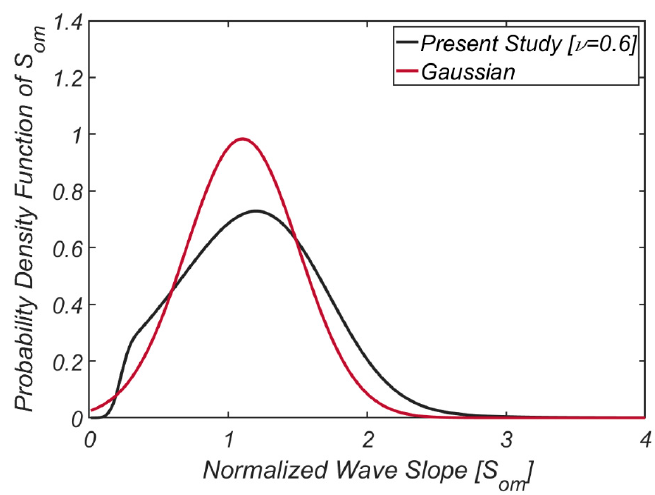
S for varying ν . Figure 6. Probability density function of S om for varying ν . om